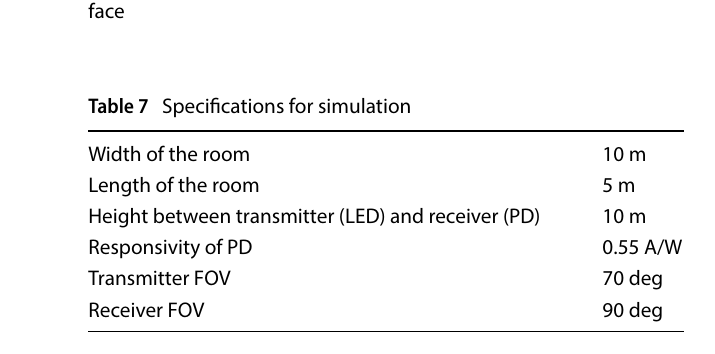
Fig. 1 System model: a horseshoe mining roadway, b mining work- face